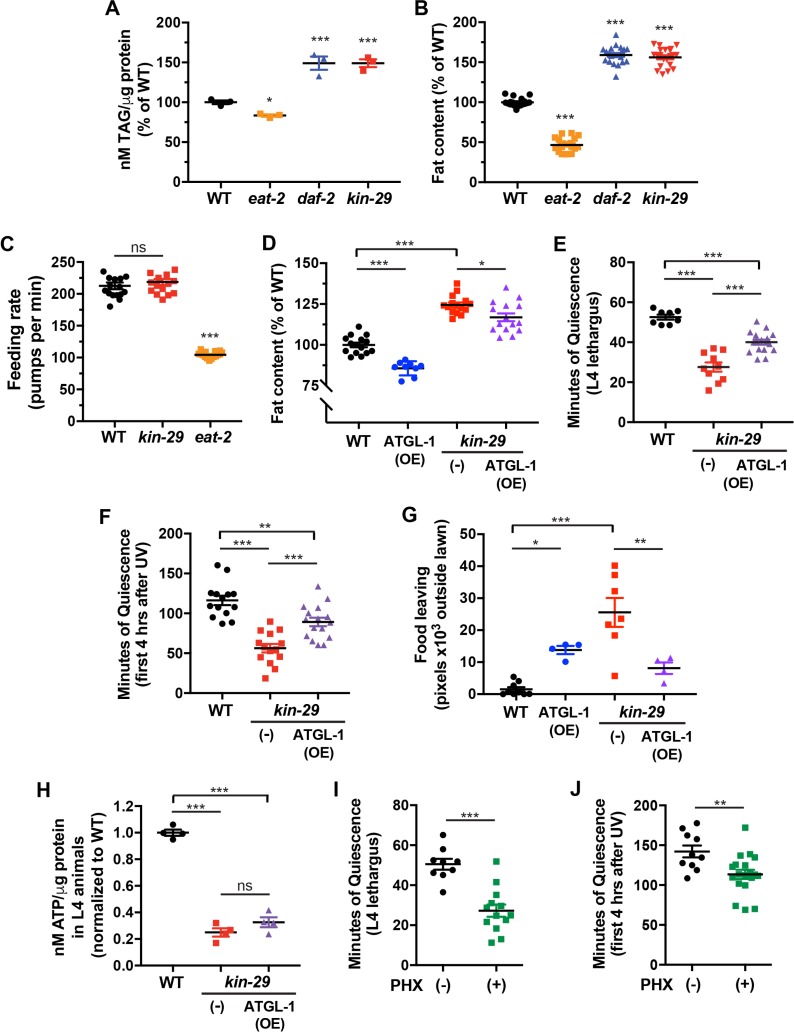
kin-29 mutants have increased total body fat and food-leaving behavior, which are partially suppressed by ATGL-1 OE.(A) Total triglyceride (TAG) levels per μg protein. The temperature-sensitive daf-2 insulin receptor mutant was raised at 15°C (permissive) and shifted to 20°C (restrictive) at the early L4 stage before TAG measurements during the adult stage. Data are represented as the percentage of total TAG in WT controls ± SEM of 3 experiments. * and *** indicate values that are different from WT at p < 0.05 and p < 0.001, respectively, by an ANOVA with Tukey multiple-comparisons test (S1 Data, Sheet 4A). (B) Fat content measured with fixative Oil Red O staining for each indicated genotype. Data are represented as a percentage of body fat in WT controls ± SEM (n = 19–21 animals). *** indicates values that are different from WT at p < 0.001 by an ANOVA with Tukey multiple-comparisons test (S1 Data, Sheet 4B). (C) The feeding rate of kin-29 null mutants is not different from that of WT control animals. Feeding rate was measured as the number of feeding motions (pumps per minute) in the presence of food for each indicated genotype with eat-2 feeding-defective mutants showing as expected reduced feeding rate. Mean ± SEM (n = 16 animals). *** indicates values that are different from WT at p < 0.001 by an ANOVA with Tukey multiple-comparisons test (S1 Data, Sheet 4C). (D) ATGL-1 OE reduces the increased fat stores of kin-29 null mutants. Fat content was measured with fixative Oil Red O staining. Data are represented as a percentage of body fat in WT control animals ± SEM (n = 9–16 animals per group). ATGL-1 (OE) indicates OE of ATGL-1. *p < 0.05 and ***p < 0.001 by an ANOVA with Tukey multiple-comparisons test (S1 Data, Sheet 4D). (E and F) ATGL-1 OE partially restores the reduced L4 lethargus/DTS (E) and UVC-induced quiescence (F) of kin-29 null mutants. Data are represented as the mean ± SEM with n = 8–17 animals for DTS and n = 14–16 animals for SIS. ***p < 0.001 and **p < 0.01 by an ANOVA with Tukey multiple-comparisons test (S1 Data, Sheet 4E and 4F). (G) ATGL-1 OE reduces the increased food-leaving behavior of kin-29 null mutants. Food leaving was measured as the area of exploration with each data point representing tracks from a population outside the bacterial lawn. Each data point represents the total number of pixels outside of the bacterial lawn of 5 animals per plate, and the horizontal line represents the mean ± SEM of individual experiments (S1 Data, Sheet 4G). Representative images are shown of food-leaving behavior, in which frames from a 12-hr video were collapsed into a single image. ***p < 0.001 and **p < 0.01 by an ANOVA with Tukey multiple-comparisons test. (H) The reduced ATP levels per μg protein in L4 larvae of kin-29 null mutants are not significantly restored by ATGL-1 OE. Data are normalized to WT and represented as the mean ± SEM of 4 experiments. ***p < 0.001 by an ANOVA with Tukey multiple-comparisons test (S1 Data, Sheet 4H). (I and J) PHX treatment results in reduced body movement quiescence during L4 lethargus/DTS (I) and after UVC exposure/SIS (J) in WT animals. Total minutes of body movement quiescence during L4 lethargus, and during the first 4 hr after UVC exposure in adults in the presence (+) of 1 mM PHX or in the absence (-) of PHX. Shown is 1 representative biological replicate of an experiment performed 4 times. Data are represented as mean ± SEM with n = 9–13 animals for DTS and n = 10–19 animals for SIS. ***p < 0.001, **p < 0.0 by an unpaired 2-tailed t test (S1 Data, Sheet 4I and 4J). ATGL-1, adipose triglyceride lipase-1; DTS, developmentally timed sleep; L4 stage, fourth larval stage; ns, not significant; OE, overexpression; PHX, perhexiline; SIS, stress-induced sleep; TAG, triacylglyceride; UVC, ultraviolet C; WT, wild type.